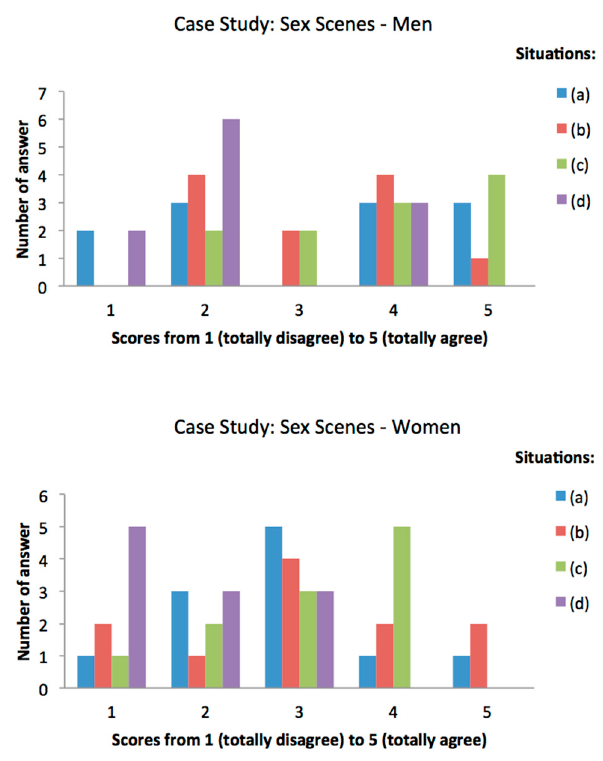
Figure 6. Answers given for the case study of sex scenes for men ( top ) and women ( bottom ).